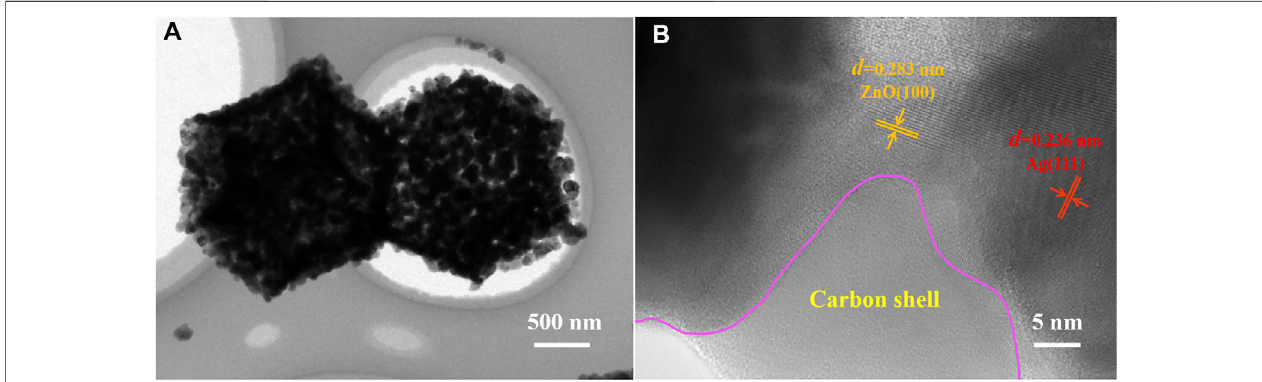
FIGURE 5 | (A) Low-magni fi cation TEM image and (B) high-magni fi cation TEM image of